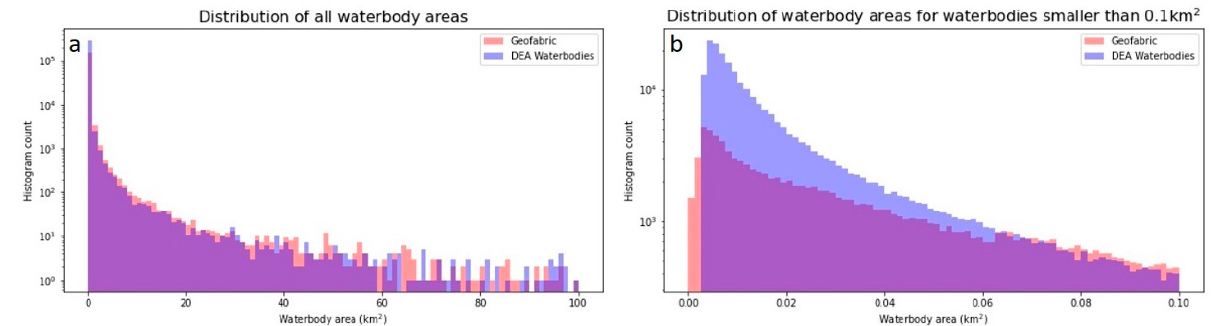
Figure 4. Size distribution of waterbodies in DEA Waterbodies and the Geofabric for ( a ) all waterbodies, ( b ) waterbodies less than 0.1 km 2 . We also performed a closer comparison on two regions, one near Moree NSW with well-defined but dynamic farm dams, and one area dominated by salt lakes near Cran- brook WA. The comparison between DEA Waterbodies and Geofabric polygons near Mo- ree is shown in Figure 5 and the comparison with Cranbrook salt lakes is shown in Figure A7.